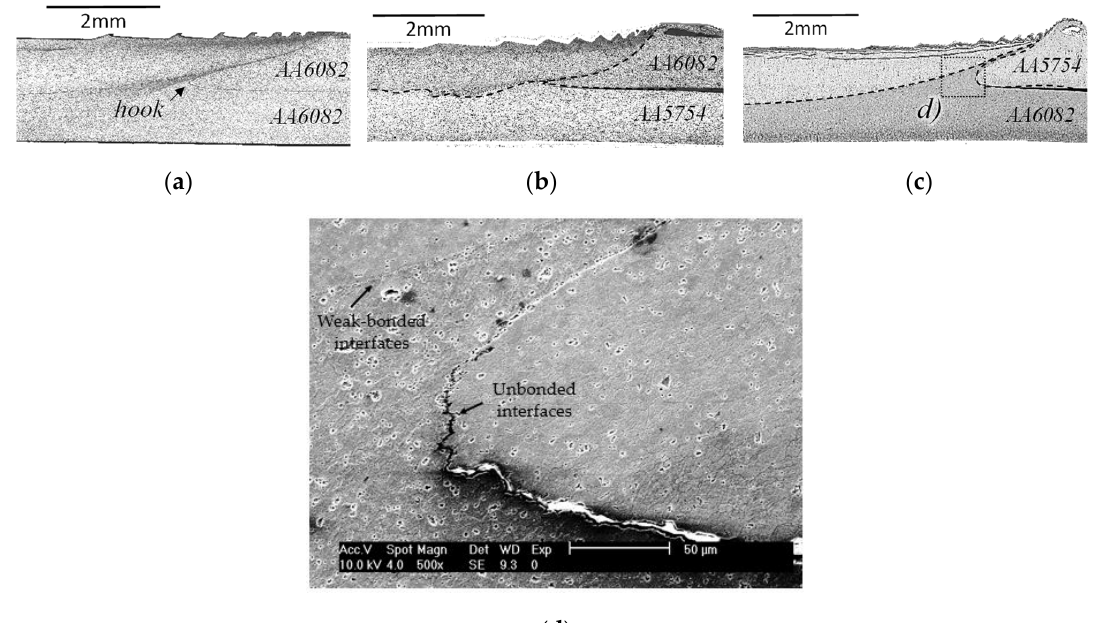
Figure 4. Transverse cross-section of the welds: ( a ) S6, ( b ) D65, ( c ) D56 macrographs and ( d ) D56 micrograph.